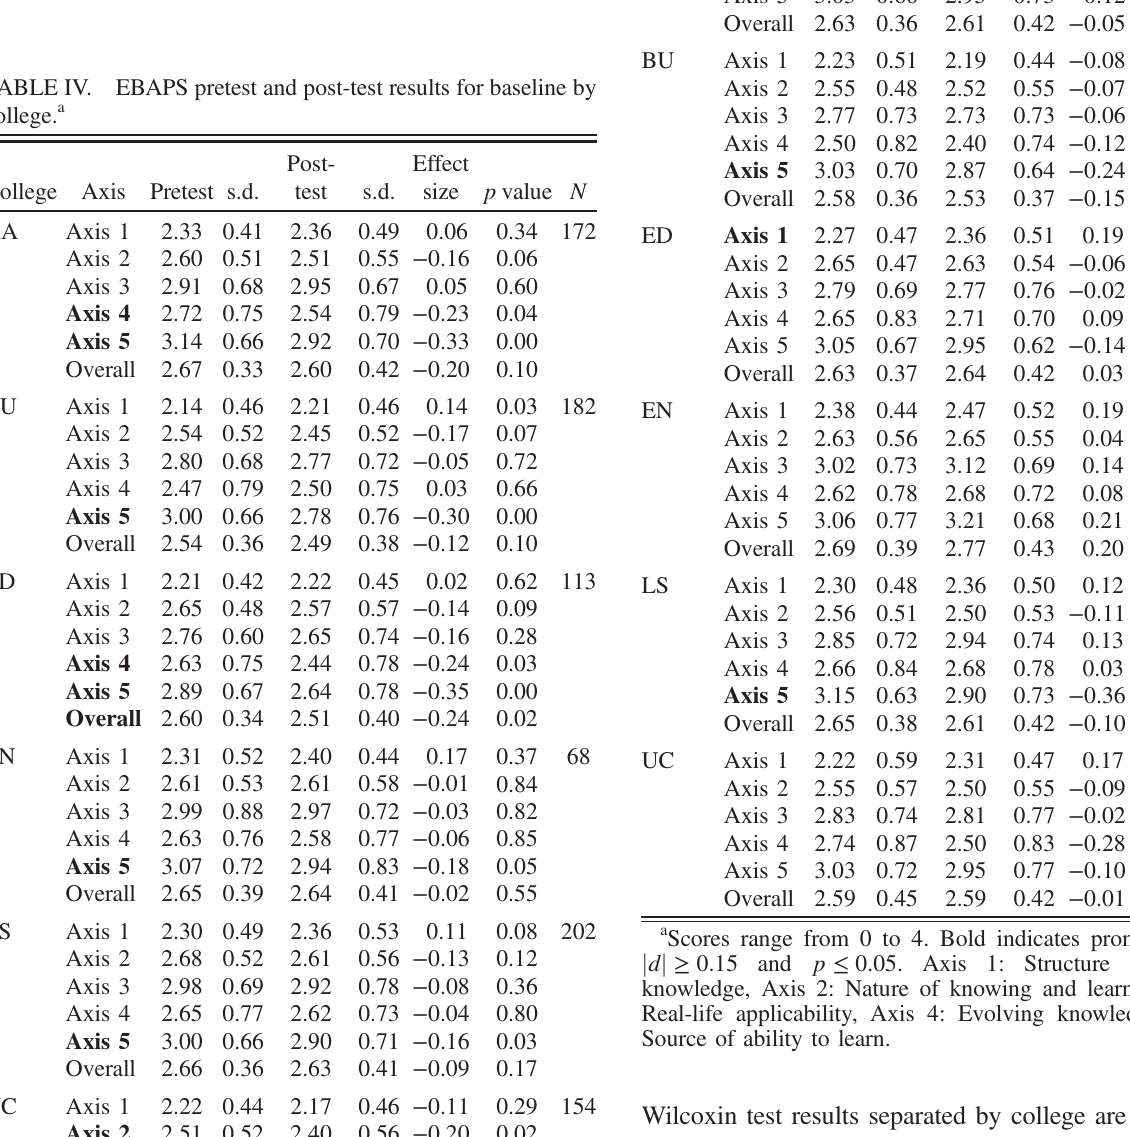
College Axis Pretest